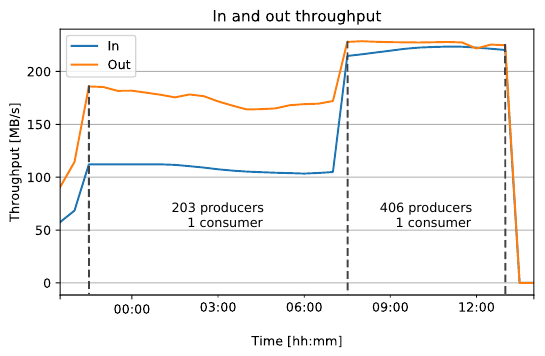
Figure 5. Kafka queue, throughput measurement: in blue the messages coming inside the queue, in orange the ones going out. Two configurations were tested and the di ff erence is clearly visible at ∼ 7:30 where the plot shows a "step". During the first part of the test, the prototype was running with 203 producers and a single consumer. In the second part, the number of producers was increased to 406 keeping only a single